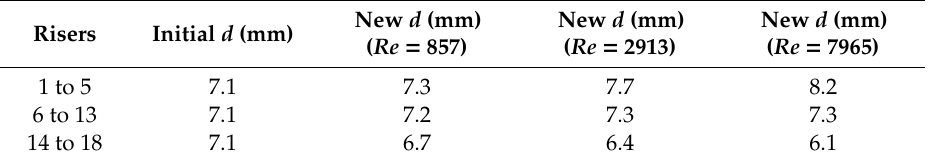
Table 4. Groups of modified riser diameters aiming to uniformity